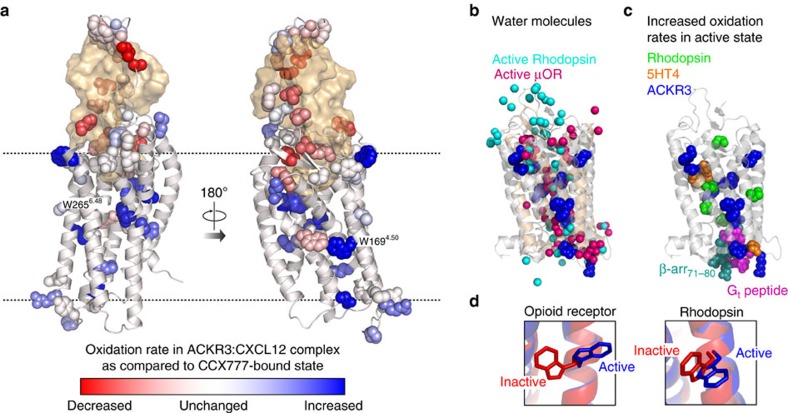
Activation of ACKR3 probed by radiolytic footprinting.(a) Mapping of radiolytic footprinting results on the ACKR3:CXCL12 complex. Side chains of all receptor residues with measured oxidation rates are shown as spheres and coloured based on the log of RateACKR3:CCX777/RateACKR3:CXCL12 using the same scheme as in Fig. 4. In the gradient colouring, blue corresponds to higher and red to lower oxidation rates in the ACKR3:CXCL12 (agonist) complex compared to the ACKR3:CCX777 (partial agonist) complex. (b) Overlay of waters from crystal structures of the μ-opioid receptor (μOR; backbone in wheat and waters in pink, PDB ID: 5c1m; ref. 43) and rhodopsin (backbone in gray, waters in cyan, PDB ID: 4x1h; ref. 41) in active conformations with residues that have increased oxidation rates in the ACKR3:CXCL12 complex. Side chains for residues with >40% higher oxidation rates in the ACKR3:CXCL12 complex are shown as blue spheres and mapped onto the rhodopsin structure. (c) Radiolytic footprinting studies of 7TM receptors mapped onto the crystal structure of active rhodopsin (PDB ID: 4x1h; ref. 41). Side chains of residues with increased oxidation rates in the active state of the receptor are shown as spheres for rhodopsin23 (Rho*-Gt>Rho, cyan), 5HT4 (ref. 24) (apo>inverse agonist bound, orange), and ACKR3 (CXCL12-bound>CCX777-bound, blue). A G-protein-derived peptide is shown in magenta and residues 71–80 of β-arrestin from the rhodopsin:β-arrestin complex (PDB ID 4zwj; ref. 47) are shown as teal spheres. (d) Conformation of W4.50 side chain in active and inactive crystal structures of opioid receptors (PDB ID 5c1m (ref. 43) and 4n6h (ref. 45)) and rhodopsin (PDB ID 4zwj (ref. 47) and 1f88 (ref. 68)).